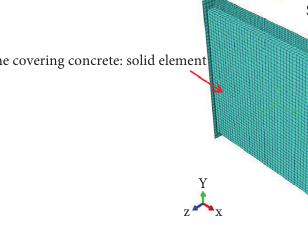
Figure 3: Finite element model of the novel